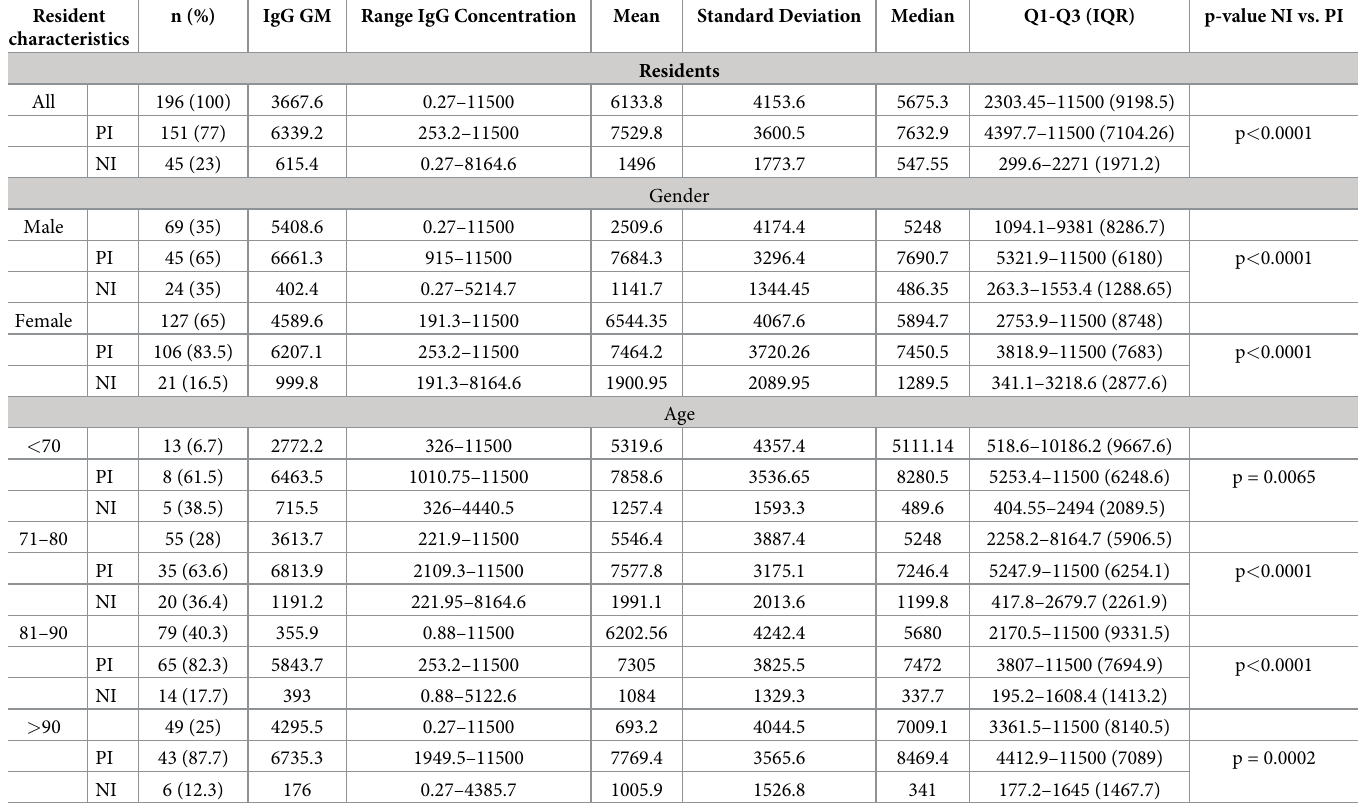
Table 1. SARS-CoV-2 spike IgG antibody titers (BAU/mL) among 196 residents in a long-term care facility after second dose of BNT162b2 mRNA COVID-19 vac- cine. More relevant statistical values are included. Resident